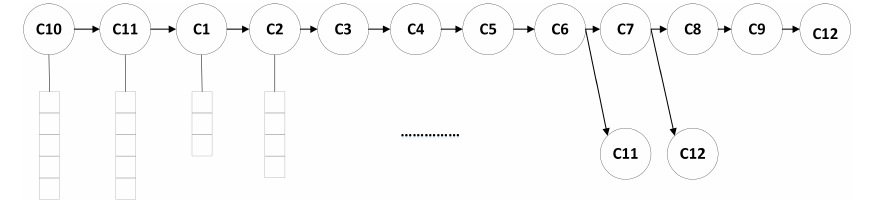
Figure 8. Directed indoor adjacency